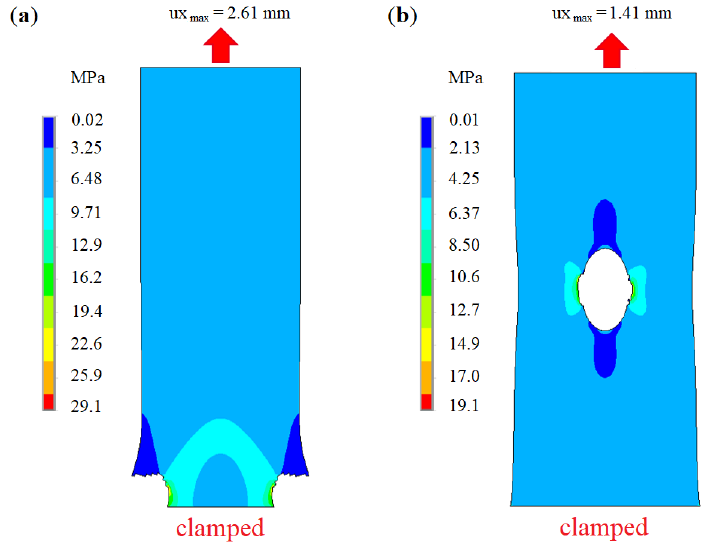
Figure 21. Von Mises stress distribution in a tensile FEM simulation of the damage of the leather stripes of Simmental breed ( a ) without and ( b ) with initial